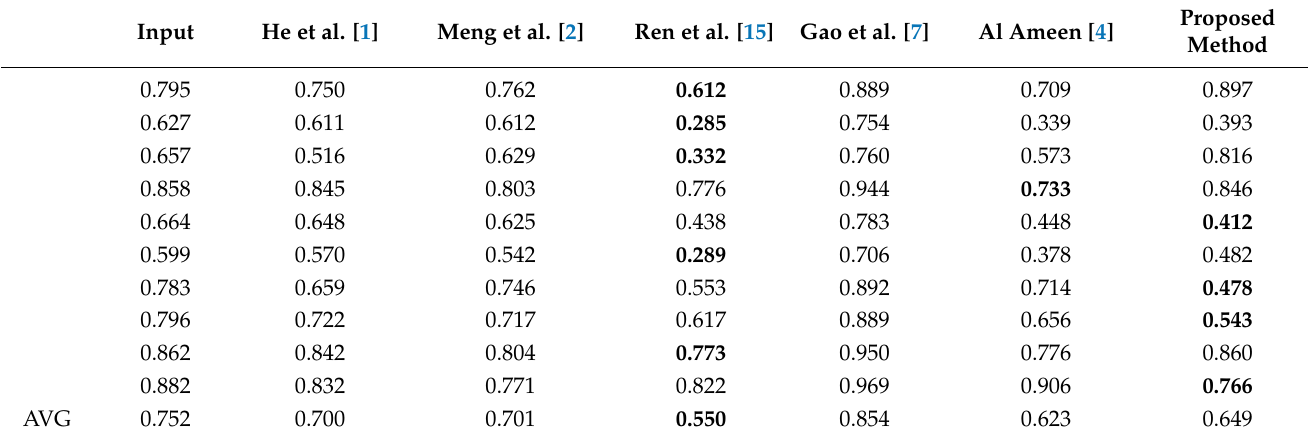
Table 7. The comparison of the HDE [35] scores from Figure 7 (If the score is low, the image is well enhanced. The lowest are indicated in bold